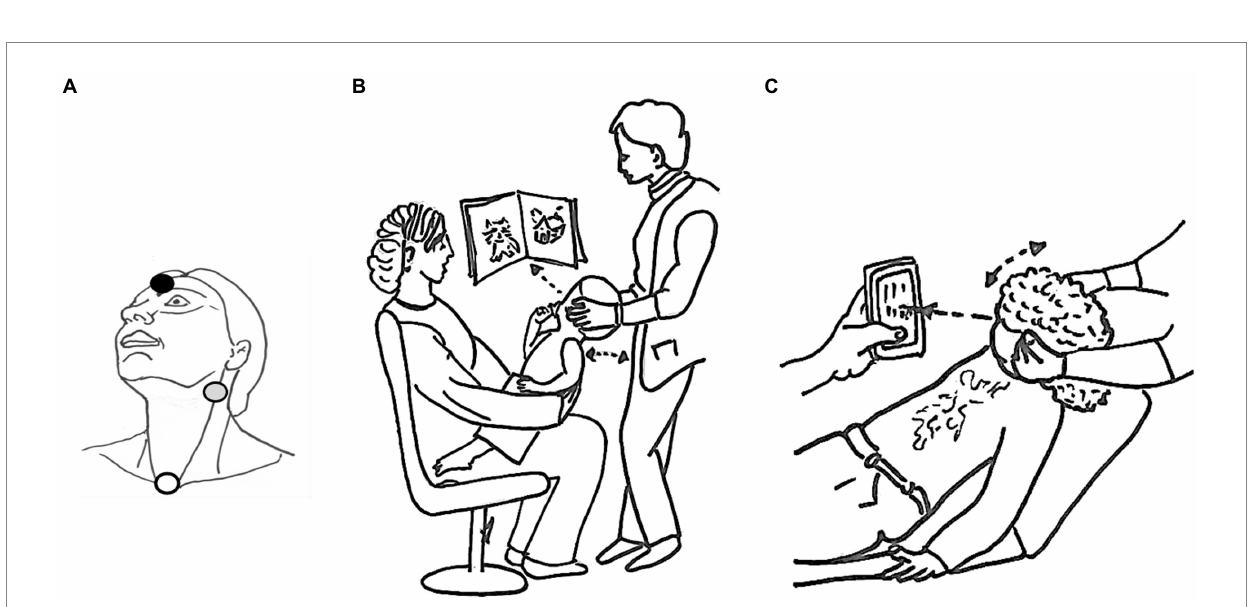
FIGURE 3 Recording protocol. The position of the surface electrodes is shown in (A) : active electrode in gray, reference in white and ground in black. The best c-VEMP test position is shown for children under 6 years of age (B) 6 years and older (C)